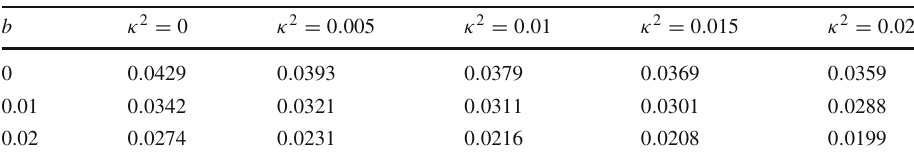
Table 1 Analytical results of T c /μ for different values of κ